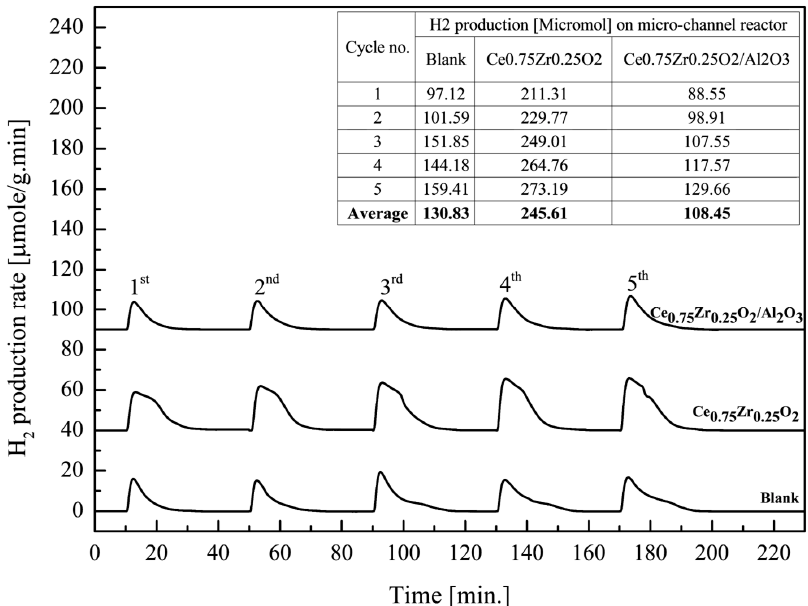
Figure 8. H 2 productivity over Ce 0.75 Zr 0.25 O 2 and Ce 0.75 Zr 0.25 O 2 /Al 2 O 3 coated in a micro-channel reactor, compared to a blank micro-channel reactor at the same reduction/oxidation temperature 700/700